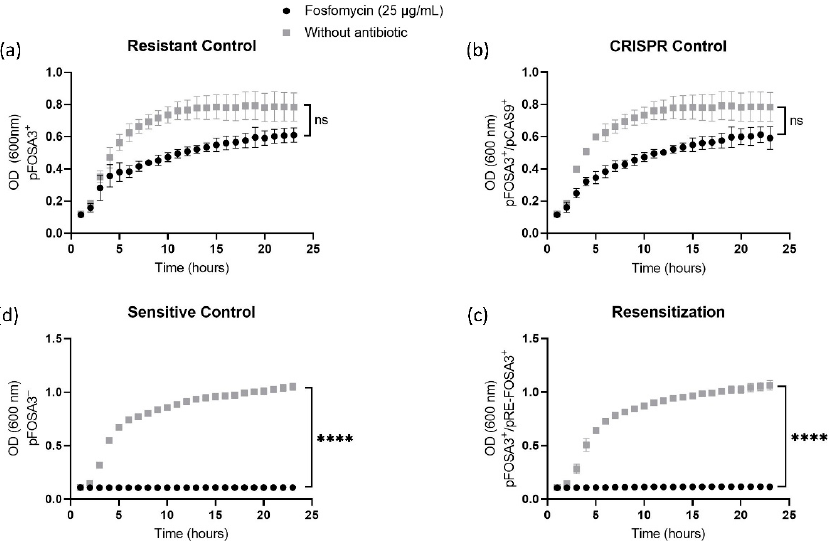
Figure 4. Growth curves for bacteria in medium with or without fosfomycin (supplemented with 25 μ g/mL glucose-6-phosphate). ( a ) Resistant control (pFOSA3 + ); ( b ) CRISPR control (pFOSA3 + /pCAS9); ( c ) sensitive control (pFOSA3 – ); and ( d ) resensitization group (pFOSA3 + /pRE-FOSA3 + ). G6P: glucose-6-phosphate. Asterisk: statistically significant difference ( p < 0.0001); ns: nonsignificant difference. Values represent the mean ± standard deviation of three in- dependent experiments (biological and technical triplicates). The inference was made using an unpaired t-test with Welch correction. p < 0.0001.